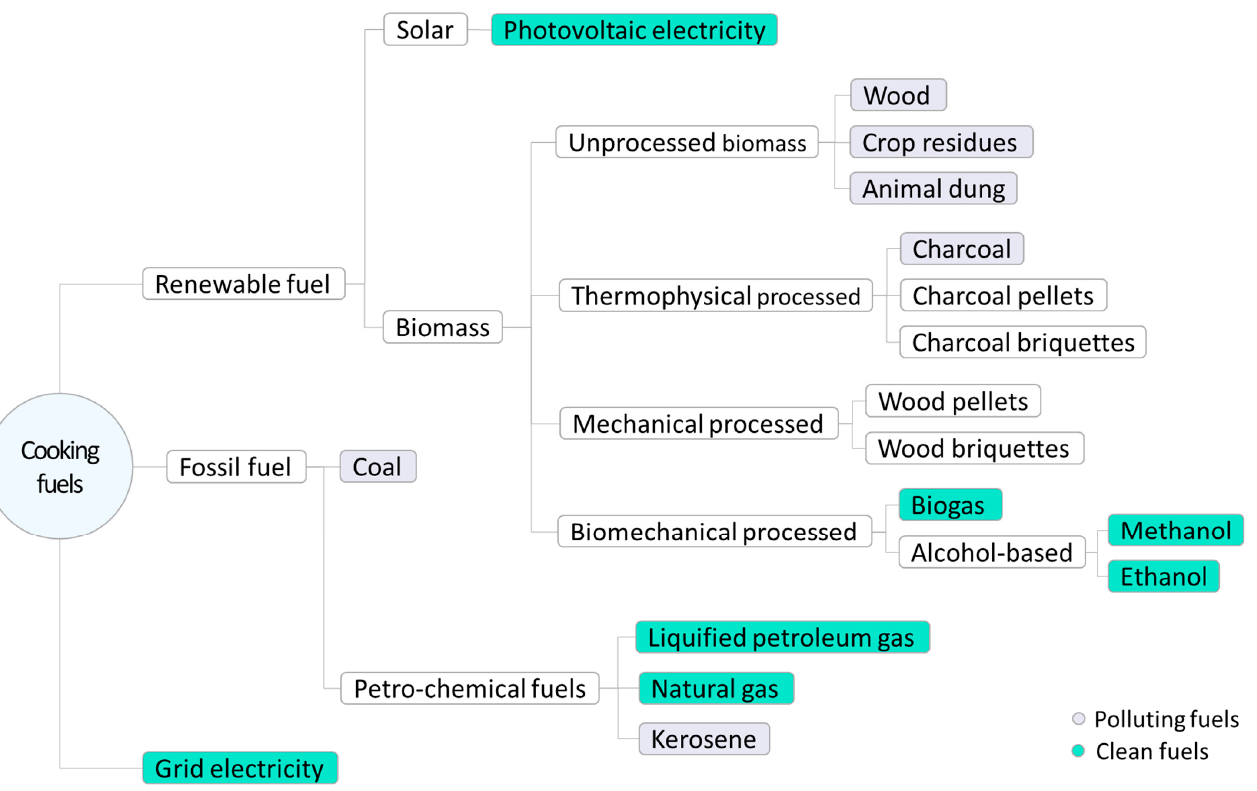
Figure 1. Classification of cooking fuels as clean or polluting at the point of